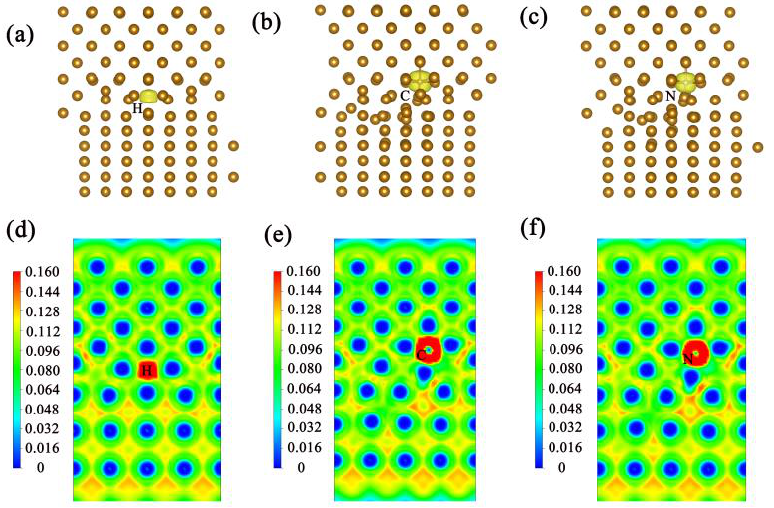
Figure 4. ELF of a H/C/N atom at the interface after optimization. ( a – c ) Three-dimensional view of ELF of a H/C/N atom at the interface, respectively. ( d – f ) Two-dimensional section view of ELF of a H/C/N atom at the interface, respectively .